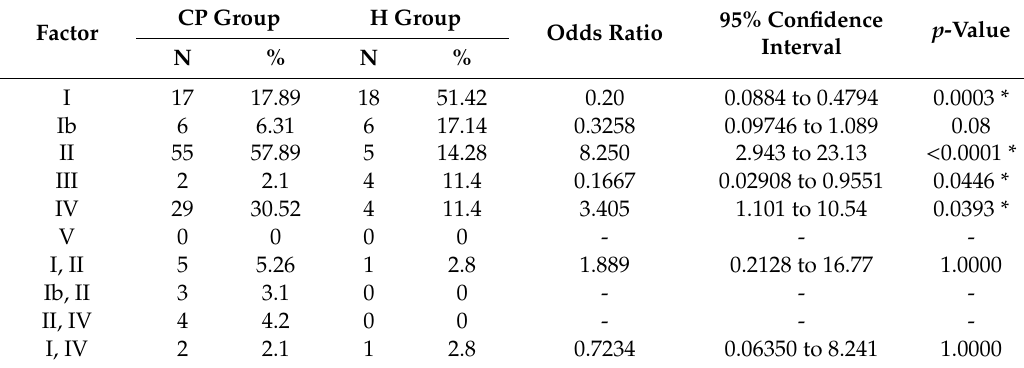
Figure 1. Agarose gel images showing the amplification of fimA genotypes: ( a ) amplification of fimA